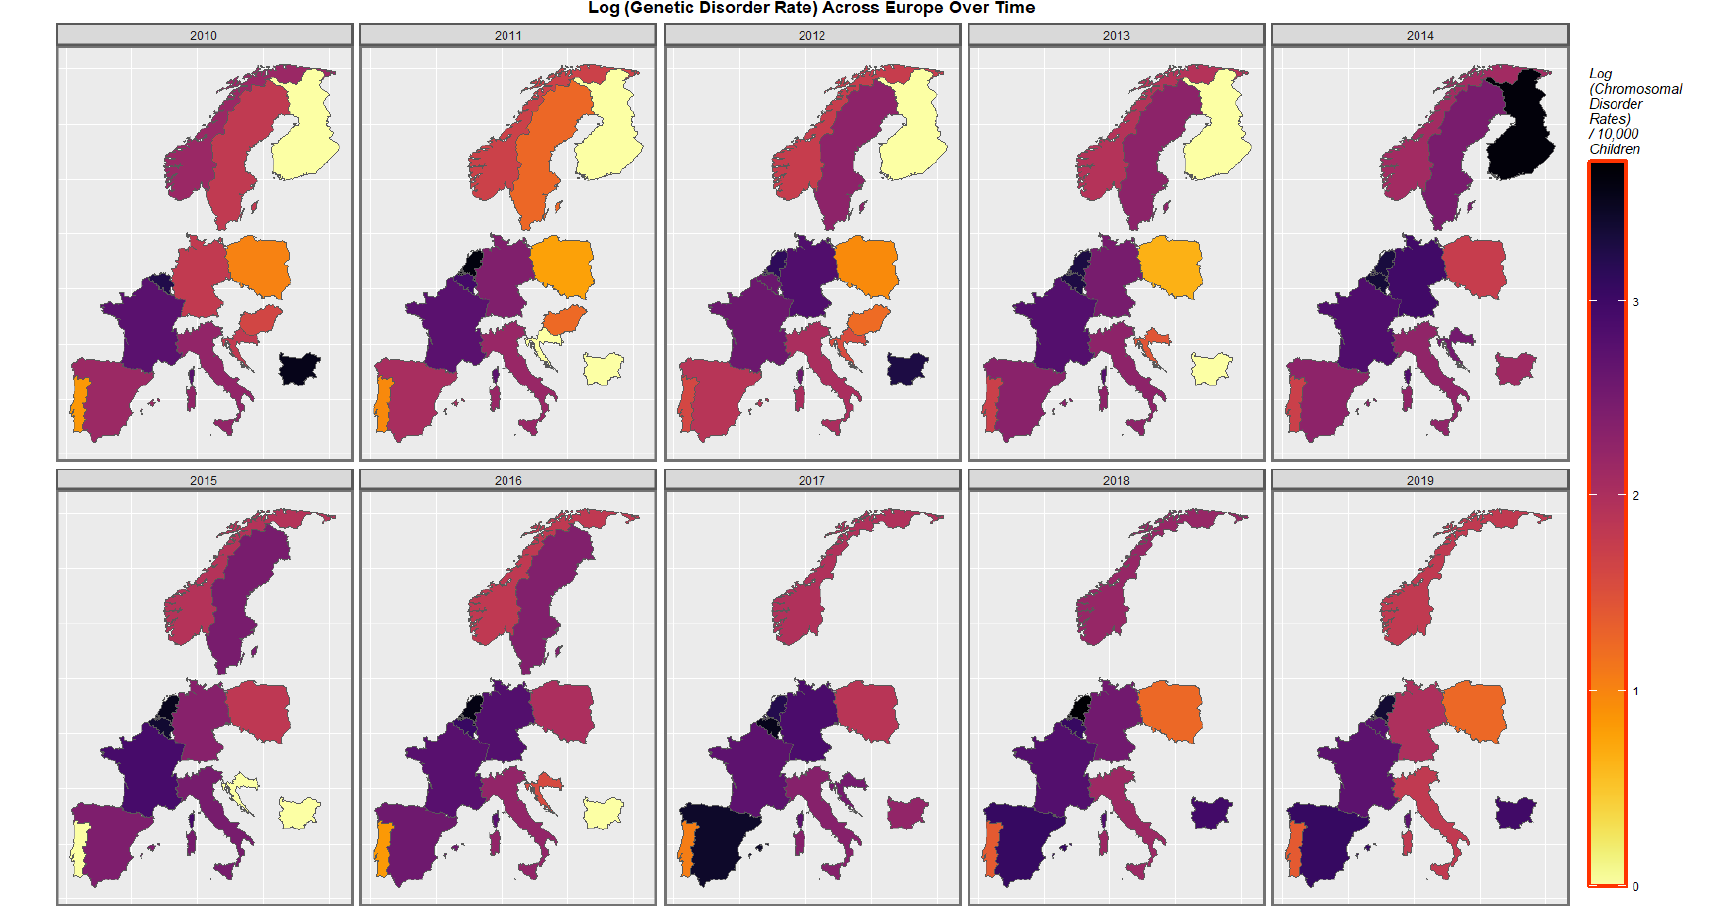
Figure 4. Sequential map-graph of genetic disorders over time in selected European nations 2010–2019.